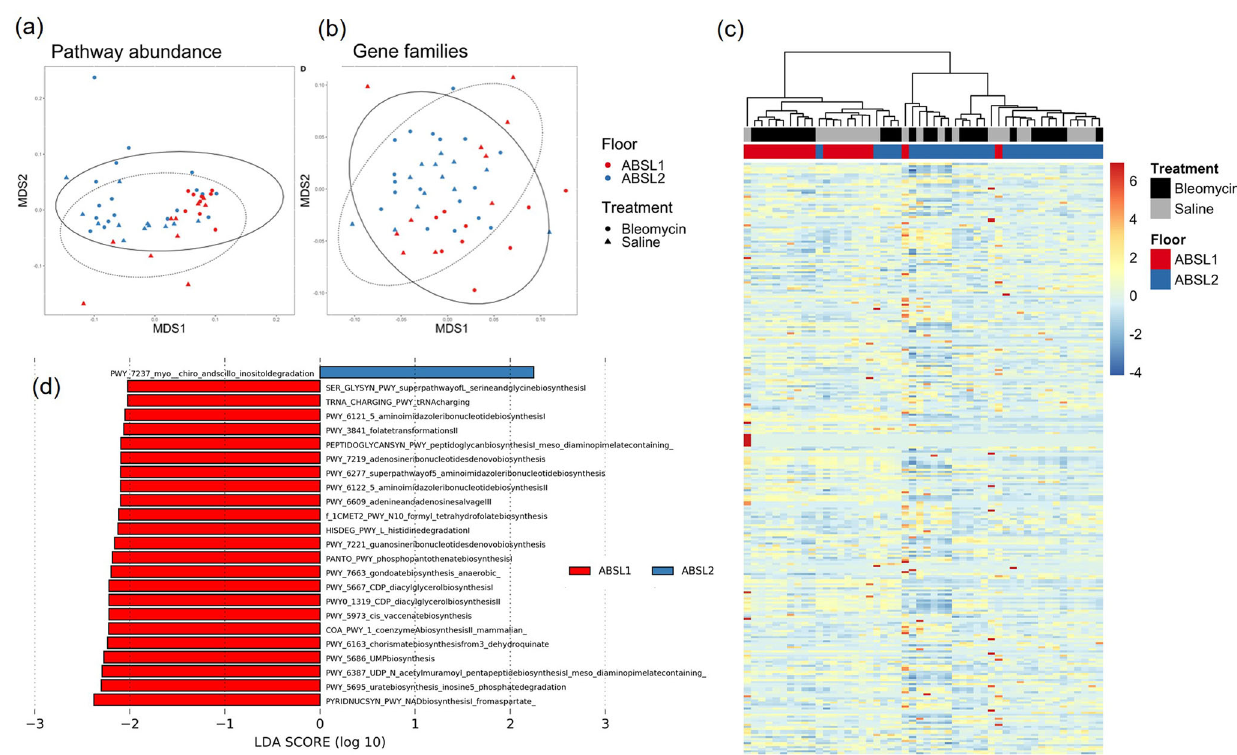
Fig. 3 Functional gene pro fi les are signi fi cantly associated with rearing environment and treatment. a MetaCyc reaction pathway abundance and b gene family abundance pro fi les using nonlinear multidimensional scaling (MDS) plots based on Jaccard distance matrices. c Heatmap showing normalized abundances of MetaCyc reaction pathway abundances between rearing environment and treatments. d Results of linear discriminant analysis showing MetaCyc reaction pathways that are overrepresented in ABSL1 or ABSL2 mice). n = 13-27 mice per cohort. The experiment was independently conducted